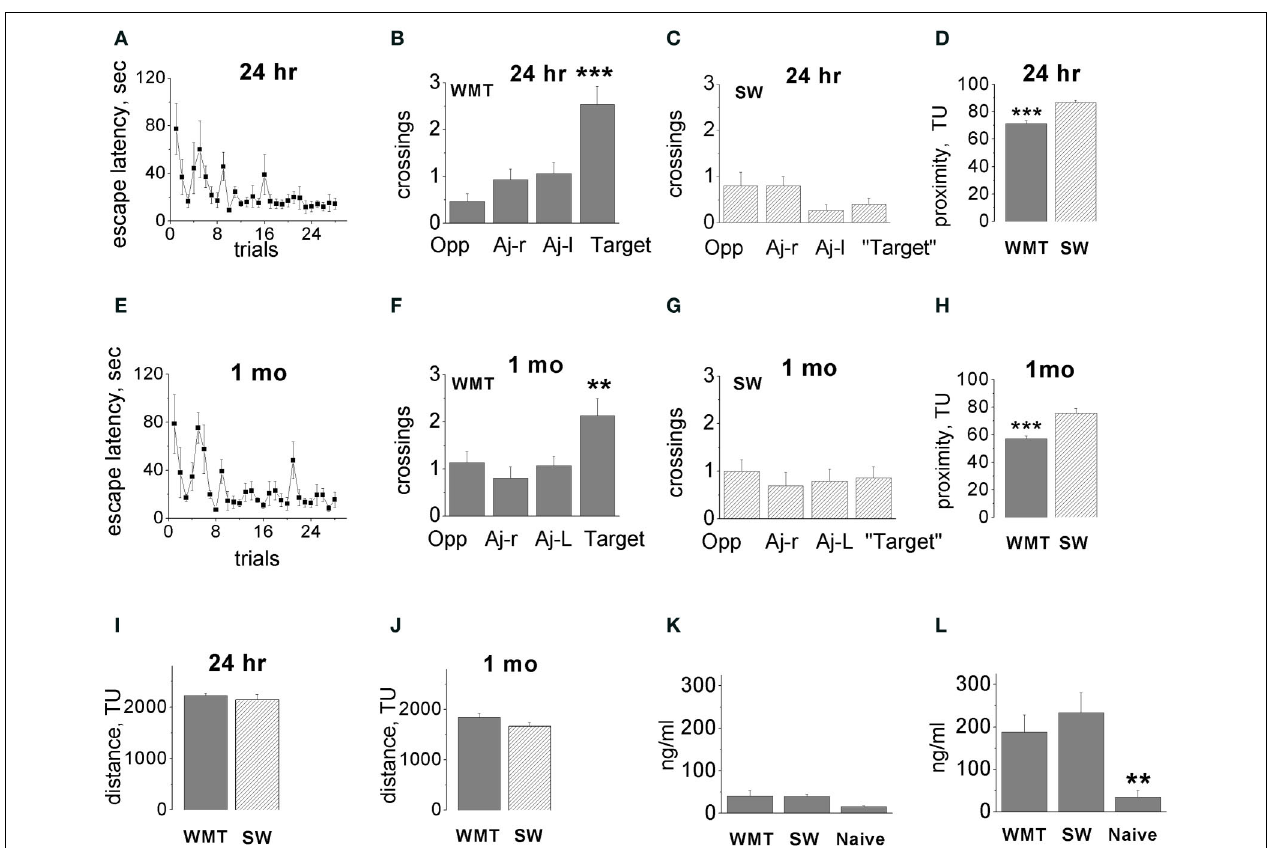
FIGURE 1 | Acquisition and long-term retention of spatial memory water-maze task. (A,E) Escape latency dynamics during WM training. (B,F) Probe tests performed 24 h (B) and 1 month (F) after 7 days of water-maze (WM) training. Bars display means ± SE of number of crossings over the target location and non-target quadrant centers. Altogether, 15 tests were conducted in fi ve triads of rats. Note the spatial bias in the swim paths of water-maze trained (WMT) rats. Target quadrant contained an escape platform during training trials, Opp-quadrant, opposite to target quadrant, Aj-r, adjacent right; Aj-l, adjacent left quadrants. (C,G) There was no spatial bias in the swim paths of swim yoked controls (SW) in the tests conducted 24 h and 1 month after the last training session. (D,H) Average proximity to the platform location during